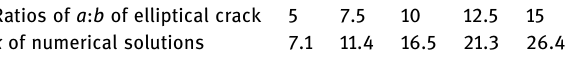
Table 6: k of numerical solution of fi ve cracked models Ratios of a : b of elliptical